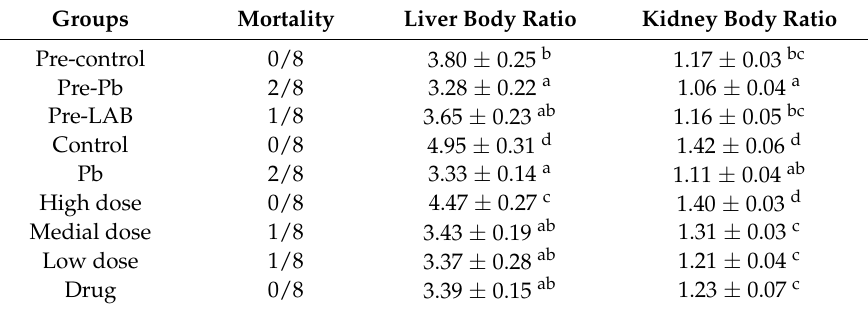
Table 3. The mortality and the viscera indices of different groups.